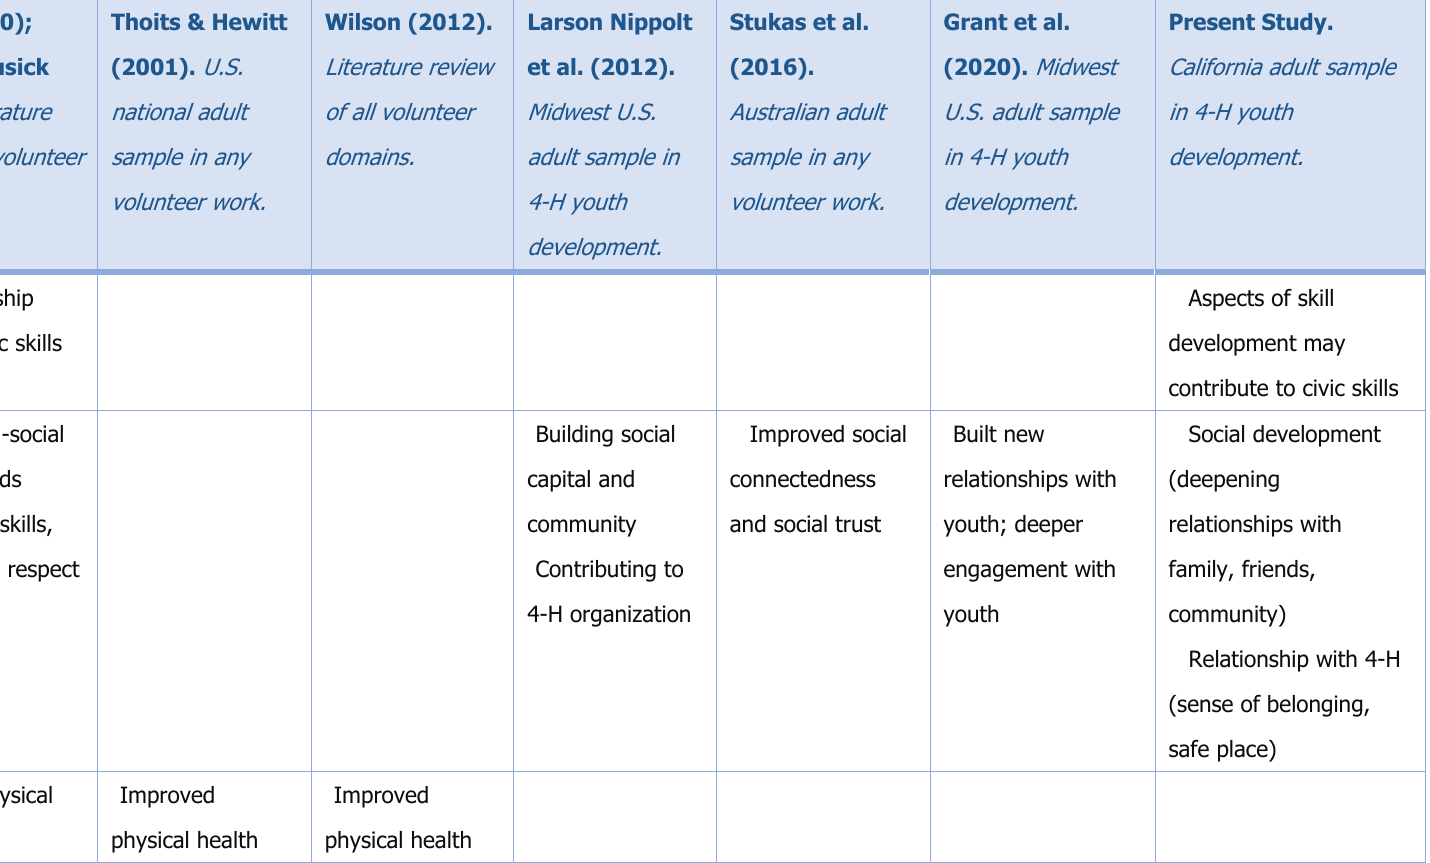
Table 4. Comparison of Volunteering Outcomes (on the five domains advanced by Wilson, 2000)